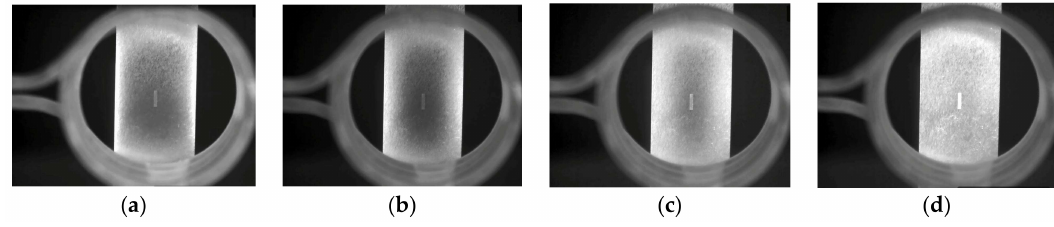
Figure 9. Thermal images after ( a ) 0.5 s, ( b ) 1 s, ( c ) 1.5 s, and ( d ) 2